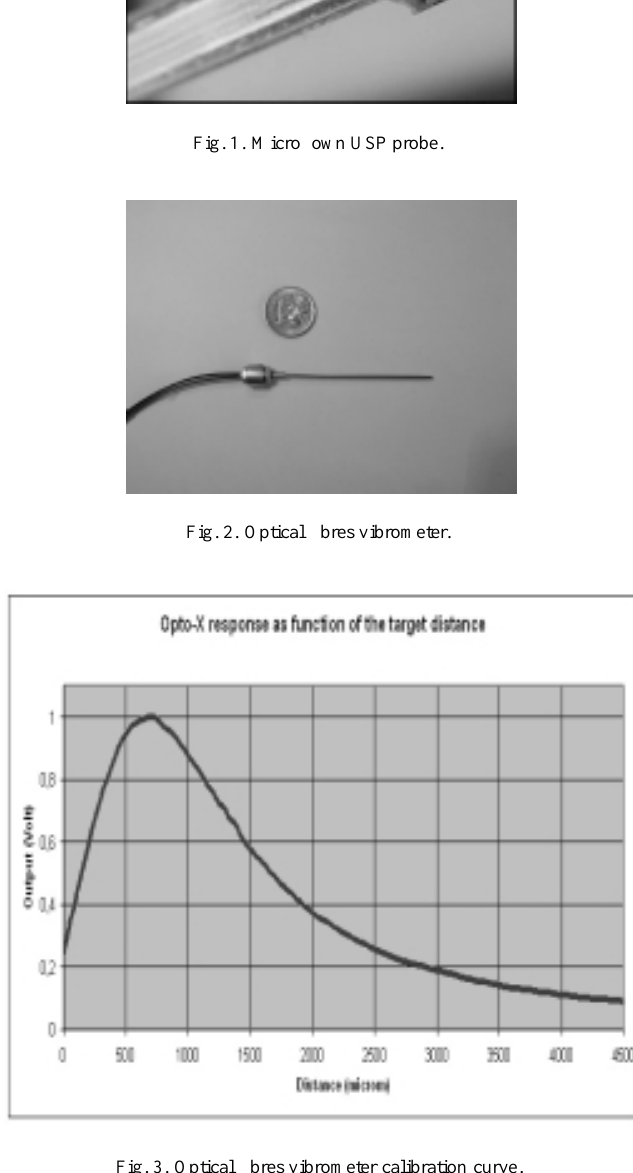
Fig. 3. Optical fibres vibrometer calibration